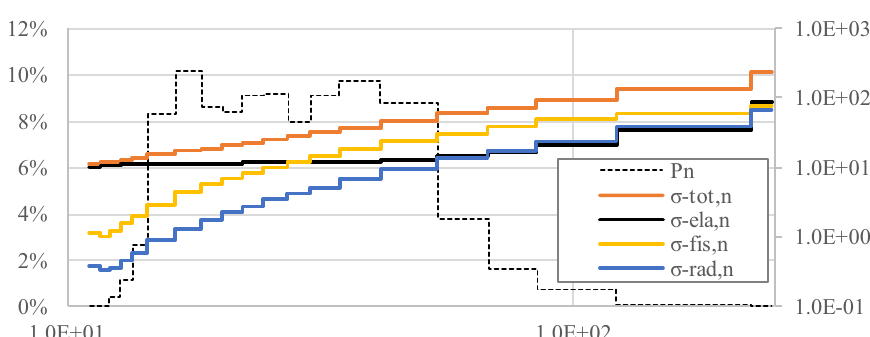
Figure 1. Probability table and average cross section of 235 U from